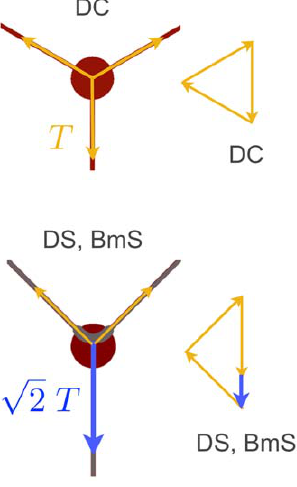
Figure 3. Vectorial analysis of tension forces on DC, DS, BmS patterns. Neuronal directions of outgrowth represented by lines of forces in the DC and BmS/DS patterns. Each vectorial representation shows the magnitude of the tensions (multiple of T, the tension exerted along the L2–L3 directions) exerted along L1 under the hypothesis of a mechanical equilibrium state at the cell level.